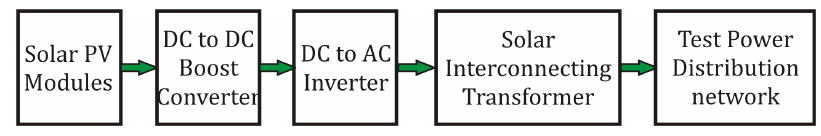
Figure 3. Block scheme of Solar PV energy